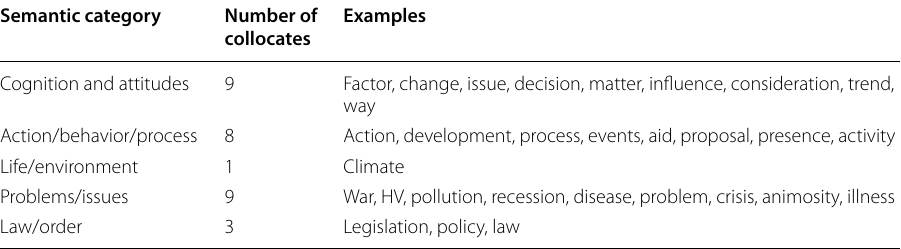
Table 8 Semantic categories of nominal subject collocates of affect Semantic category Number of collocates